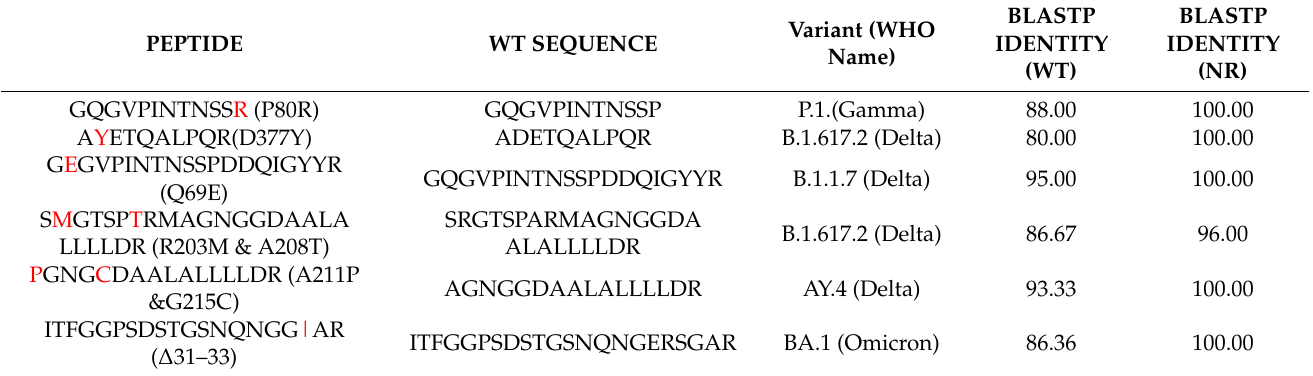
Table 1. Verified peptides with variant-specific sequences to the SARS-CoV-2 nucleocapsid